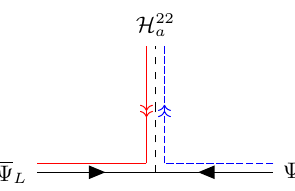
Figure 2 . Feynman diagram representing the direct coupling of second generation fermions to the H 22 Higgs components, which ultimately mix with the H a Yukawa couplings.